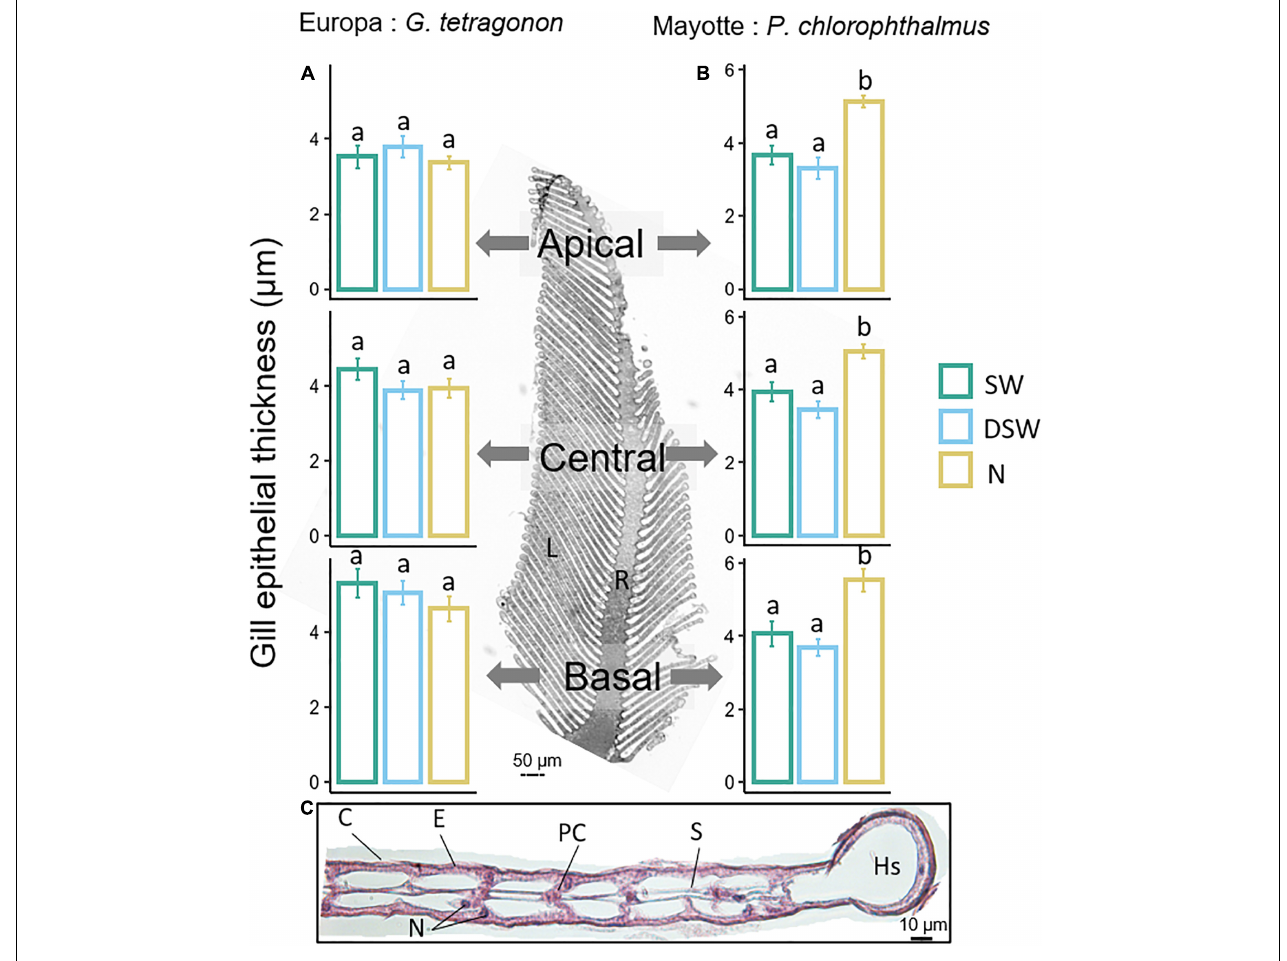
FIGURE 6 | Histological analyses from transverse sections of GT and PC posterior gills exposed to seawater (SW), diluted seawater (DSW) and 10 mg.L - 1 ammonia-N (N). The photograph illustrates a histological cross section of a posterior gill through the raphe (central part, R) and the lamellae (L). (A,B) Epithelial thickness measurements of gill lamellae across the longitudinal axis of posterior gills of GT and PC. Values are means ± SEM ( N = 3–8 per treatment). Different letters represent statistically significant differences between treatments at p < 0.05 obtained from a one-way ANOVA followed by Tukey post hoc comparisons. (C) Histological section of a gill lamella of Gelasimus tetragonon (cross section). C, cuticle; E, epithelium; N, nucleus; PC, pillar cell; S, septum; Hs, hemocoelic